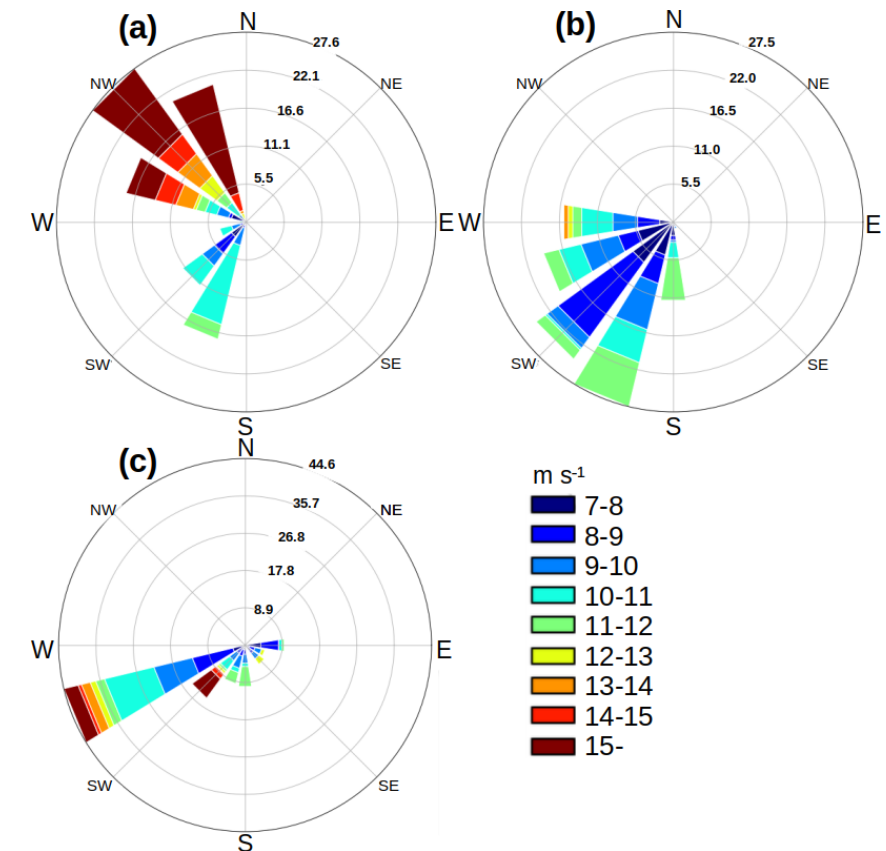
Figure 5. Windroses showing the wind direction and 10m wind speed (ms − 1 ) in the areas W (a) , SW (b) and S (c) , for the favorable days on the Baltic Sea area during 2000–2010 based on RCA4 data. Colors refer to wind speed (ms − 1 ) and the number on the circles to the frequency (%) of a wind component relative to all wind components during favorable days in the considered